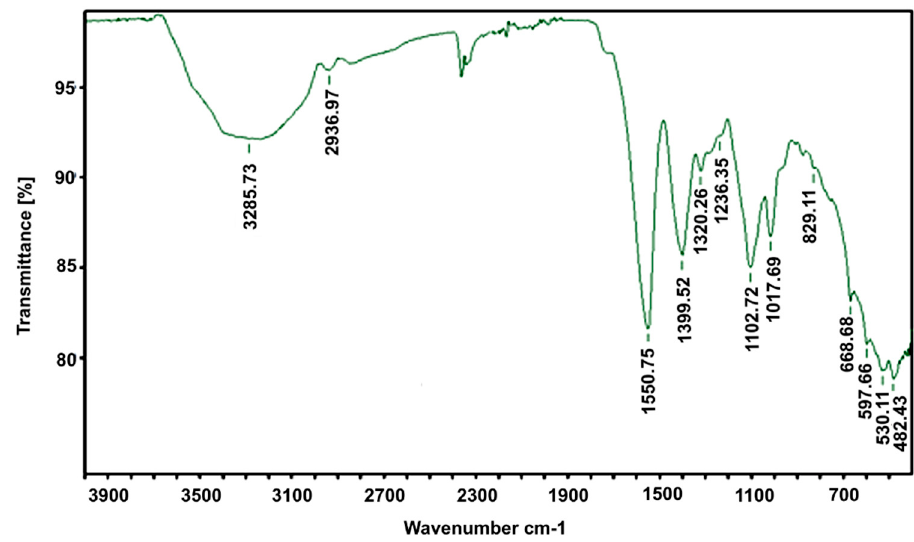
Figure 2. FTIR spectrum of PWPs extracted from P. major L. leaves .